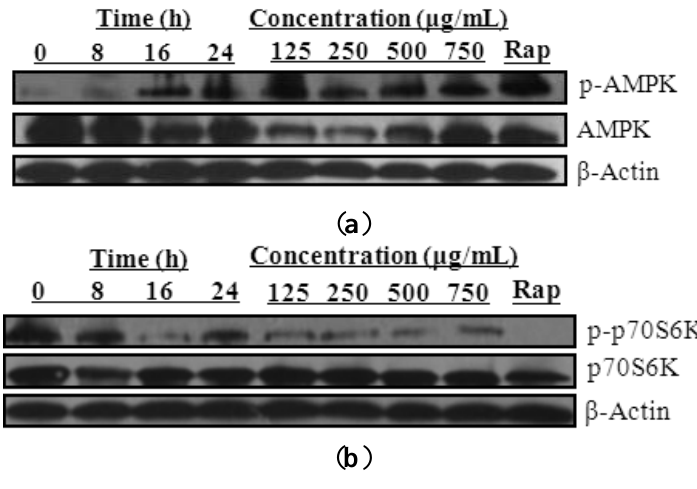
Figure 3. Radix Polygalae ethanol extracts activate the AMPK-mTOR signaling pathway. ( a ) PC-12 cells were treated with Radix Polygalae ethanol extract at the indicated time and concentrations, respectively. Cells treated with 0.3 μM of rapamycin (Rap) for 24 h were used as the positive control. Cell lysate was then harvested and analyzed for p-AMPK and AMPK; or ( b ) p-p70S6K and p70S6K,